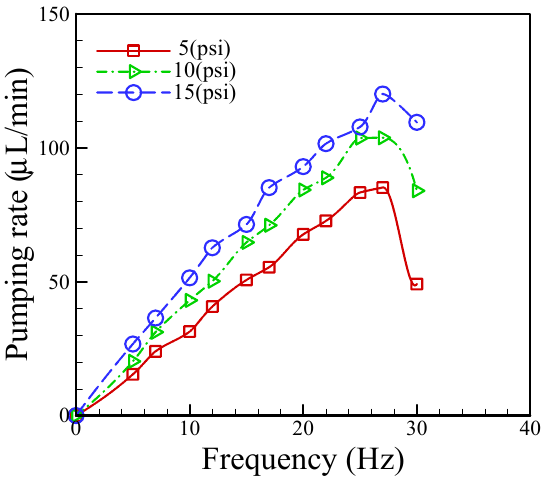
Figure 4. Liquid pumping rate profiles of the integrated pneumatic micropump at various applied pneumatic pressures (5, 10, and 15 psi) and frequencies (5–30